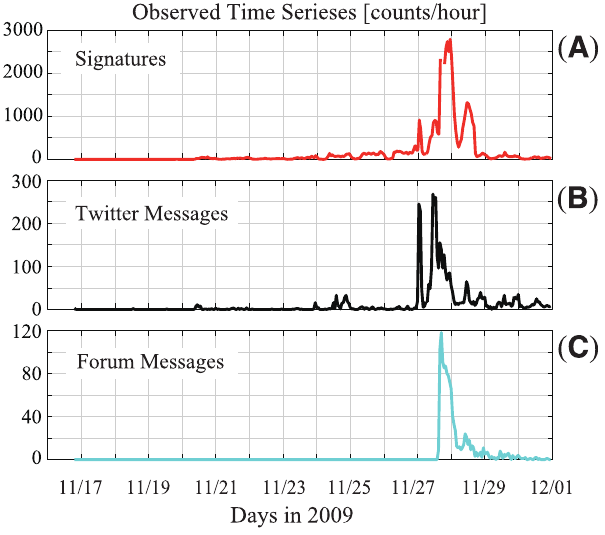
Figure 1. The observed numbers of signatures and messages of social media. The observed hourly-counted numbers of (A) signatures ( y n ), (B) Twitter messages including ‘‘Kampo’’ and ‘‘Signatures’’ ( w n ), (C) Internet-forum messages ( v n ).